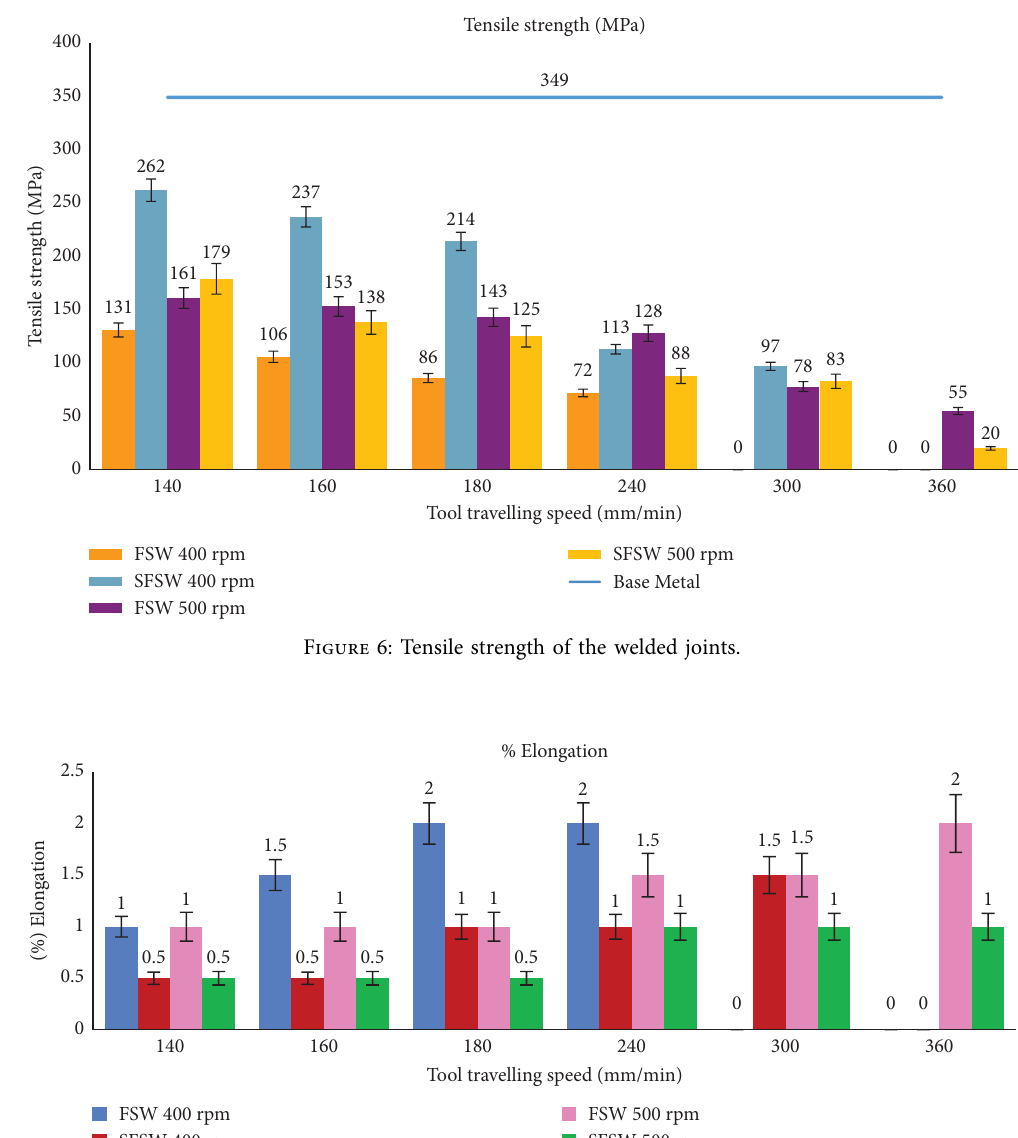
Figure 7: % Elongation of welded